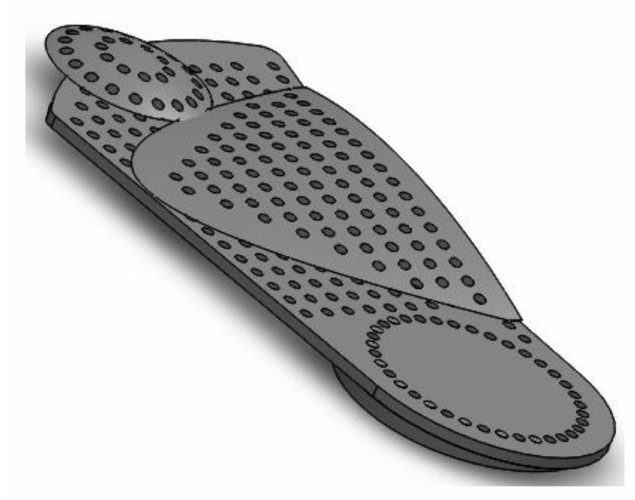
Figure 6. Modular plantar orthosis system to be inserted in the